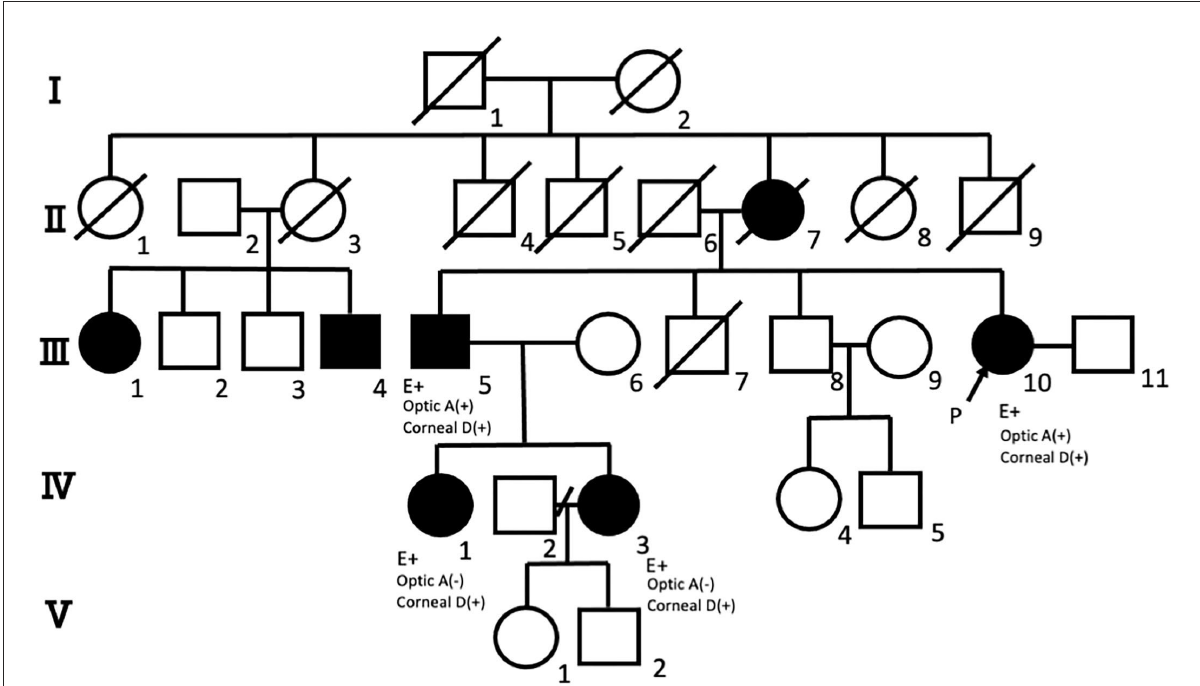
FIGURE1 Pedigree of the family with dentatorubral-pallidoluysian atrophy (DRPLA), including the four patients in this study. Pedigree of the family with DRPLA showing generations ( Roman numerals ) of affected ( solid symbols ) and unaffected ( open symbols ) members. Roman numerals represent generation numbers. Squares indicate male members; circles, female members; P, proband; oblique, deceased; optic A, optic atrophy; corneal D, corneal endothelial degeneration. Genetic analysis (E + ) shows the expanded allele of CAG repeats at the DRPLA locus (III-5, III-10, IV-1, and